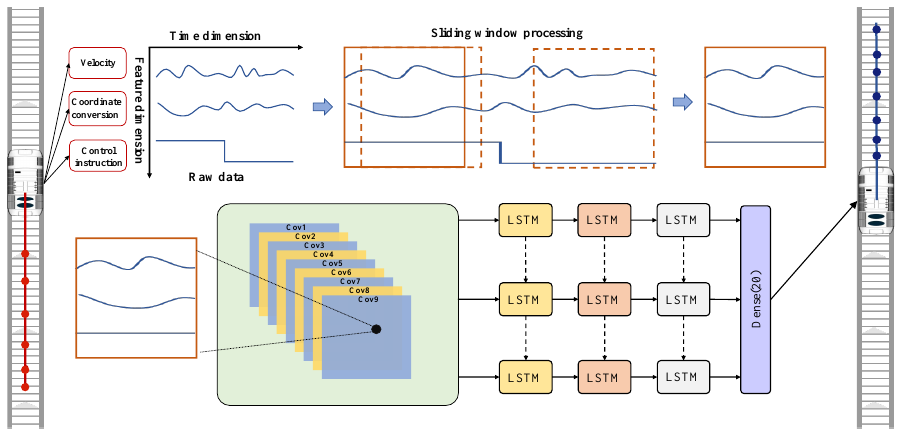
Figure 4. The proposed hybrid